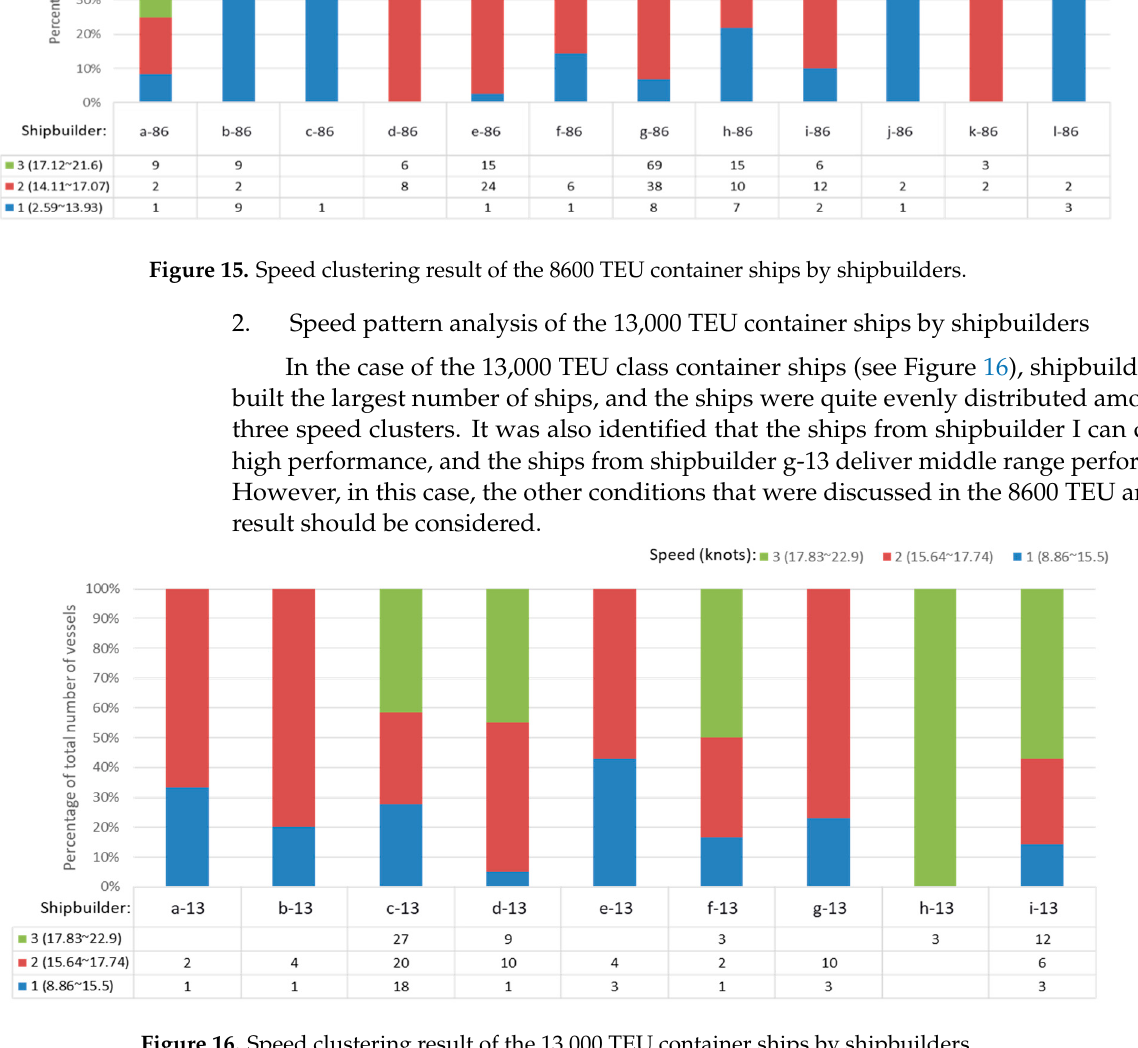
Figure 16. Speed clustering result of the 13,000 TEU container ships by shipbuilders.